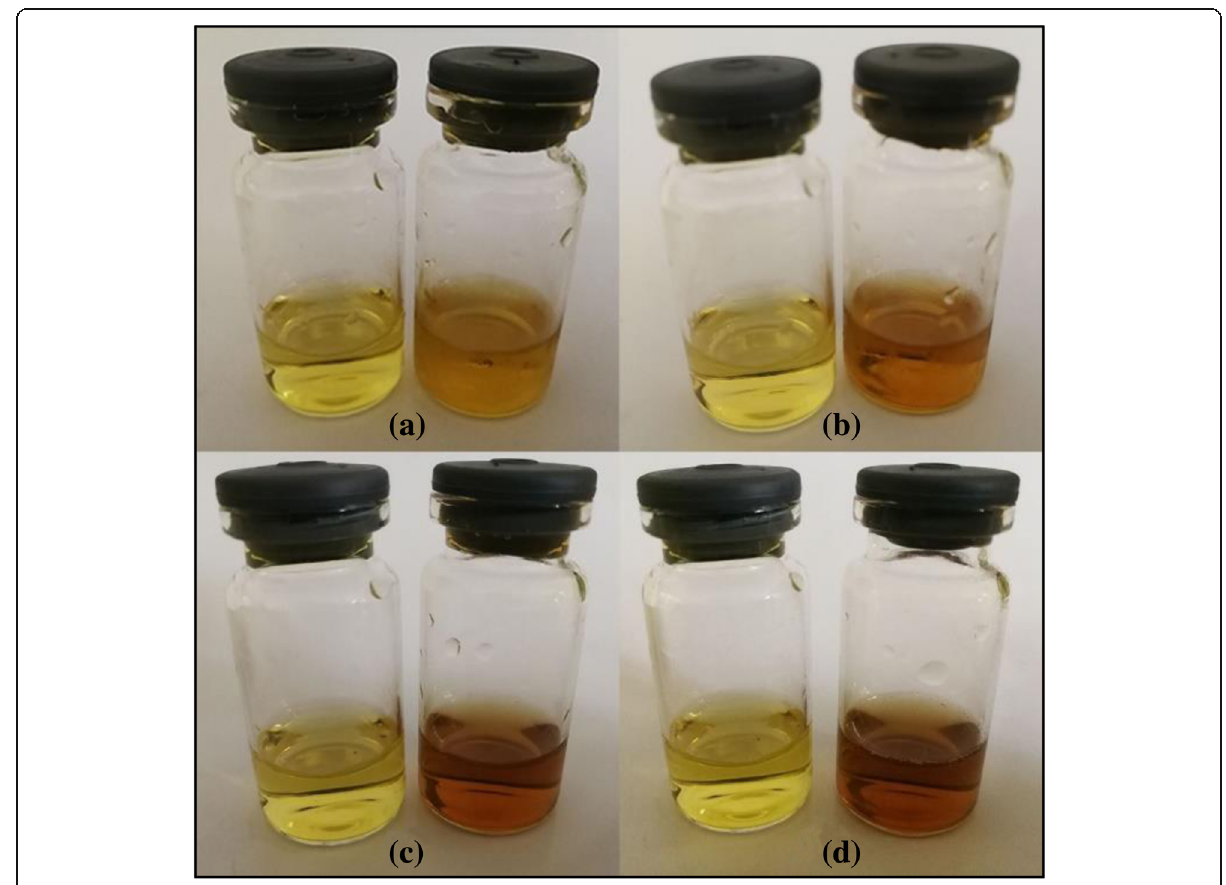
Fig. 3 Silver nanoparticles without citrate (right panel) and with citrate (left panel) for ( a ) 5, ( b ) 10, ( c ) 20 and ( d ) 30